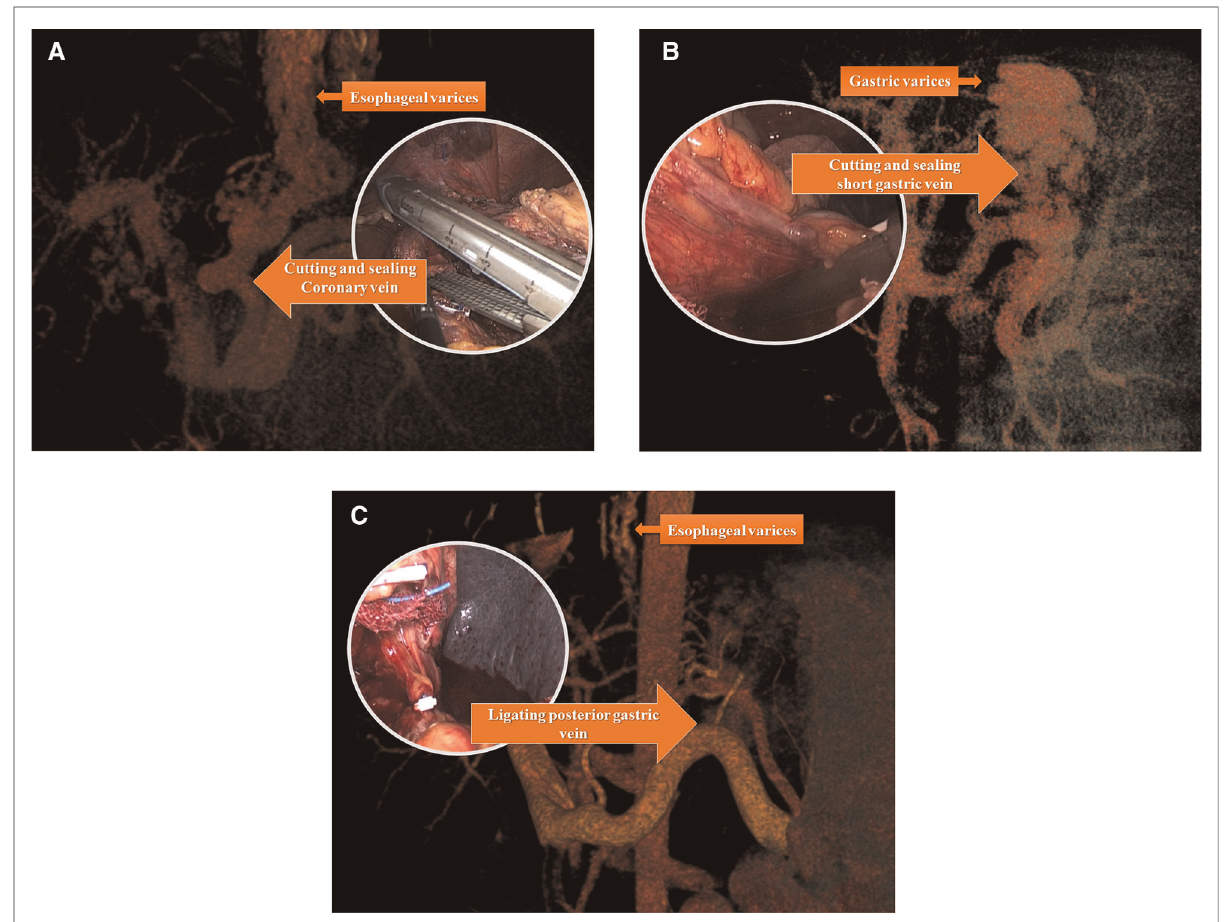
FIGURE 3 Individualized devascularization procedure usually disconnected major vessel trunk include coronary vein (left gastric vein) ( A ) posterior gastric vein ( B ) and short gastric vein ( C ) individually or in combination according to preoperational vascular